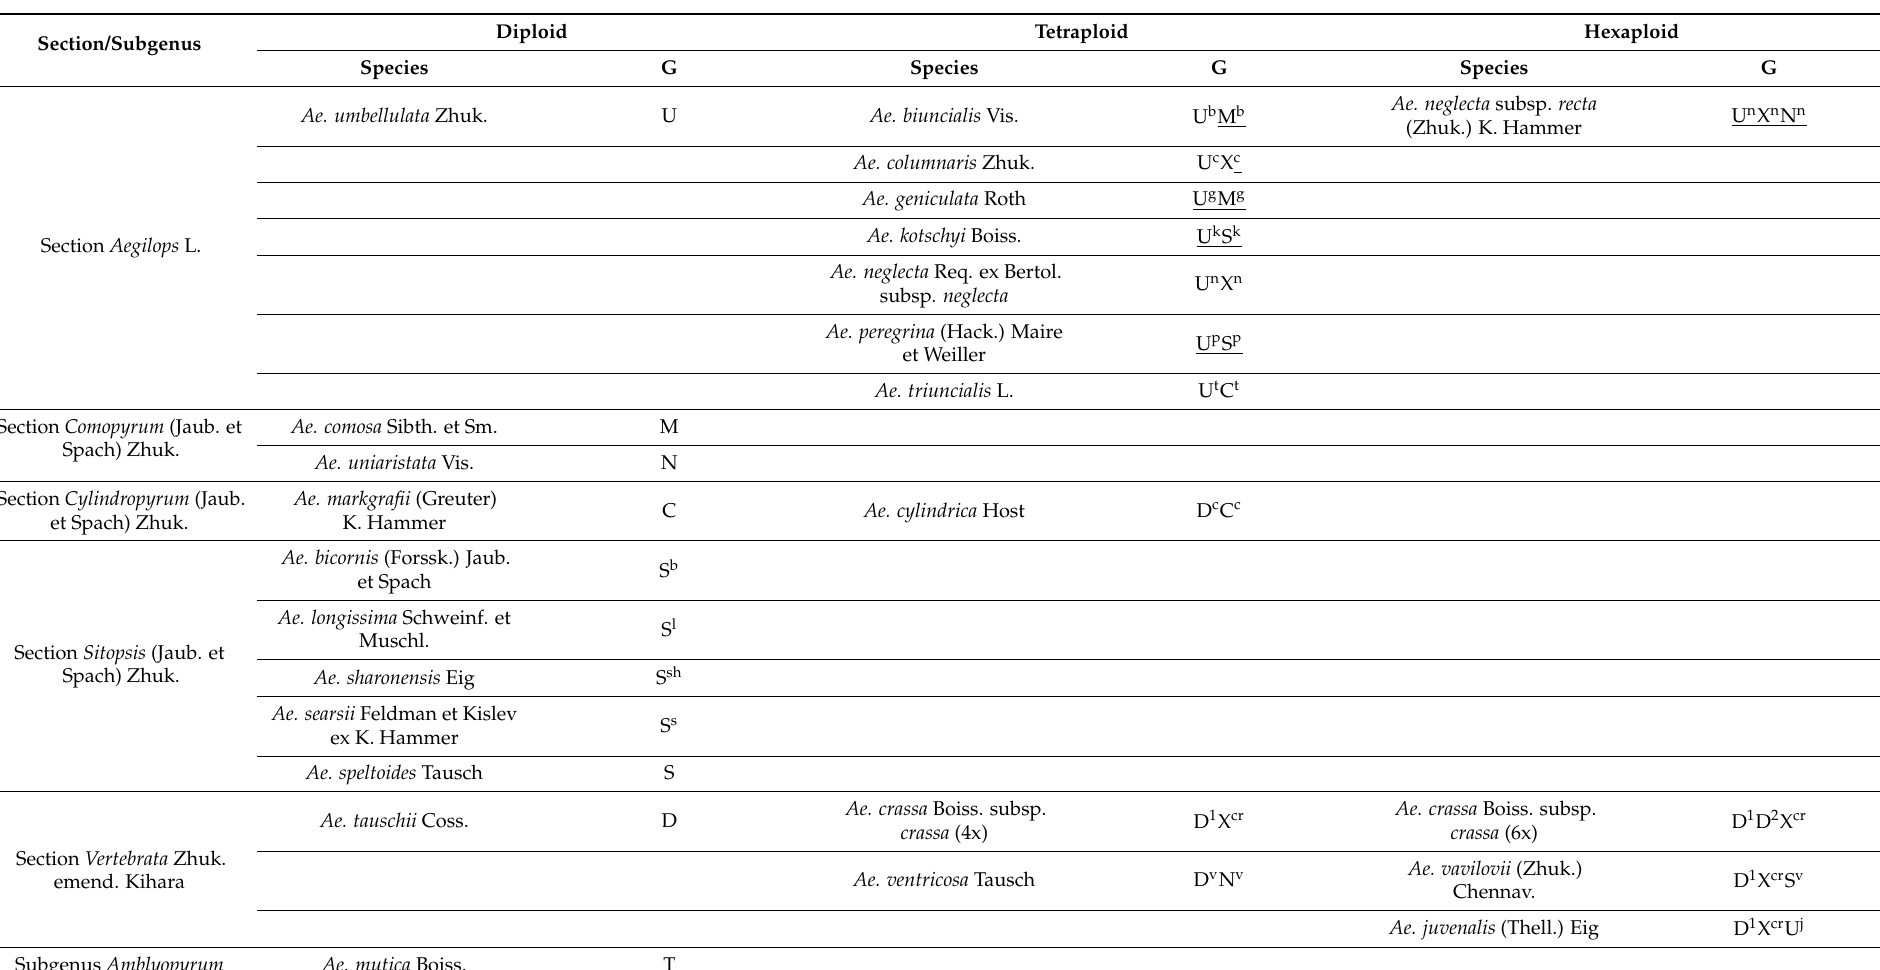
Table 4. Aegilops species and their genomic formulae (per haploid genome) considered in this review (G). Genomic formulae of tetraploids and hexaploids are cited as “female × male parent.” Capital letters specify genome types, while superscripts indicate modifications.